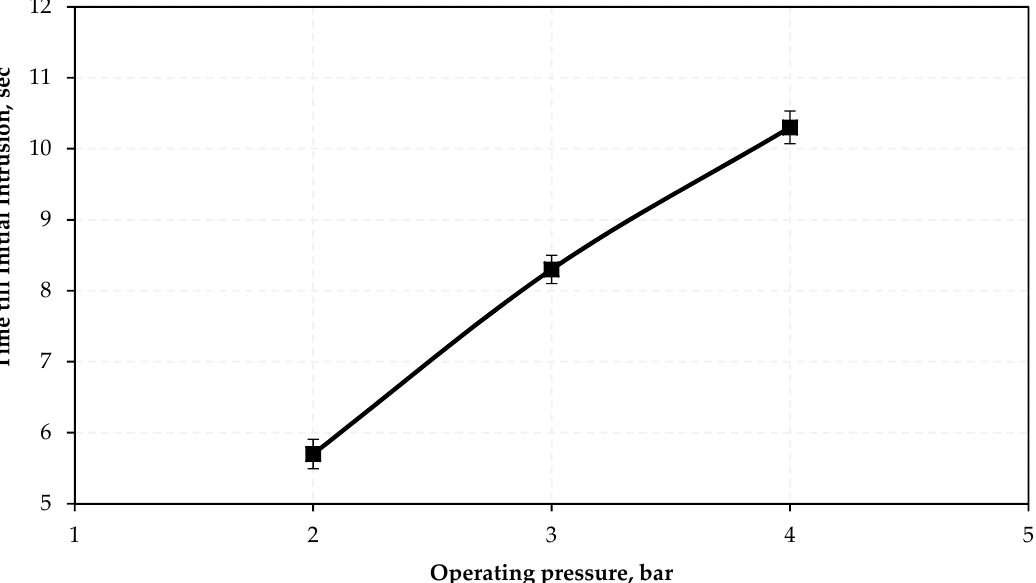
Figure 3. Minimum time required for a contaminant to initially intrude the system for an orifice size of 0.5 inch.